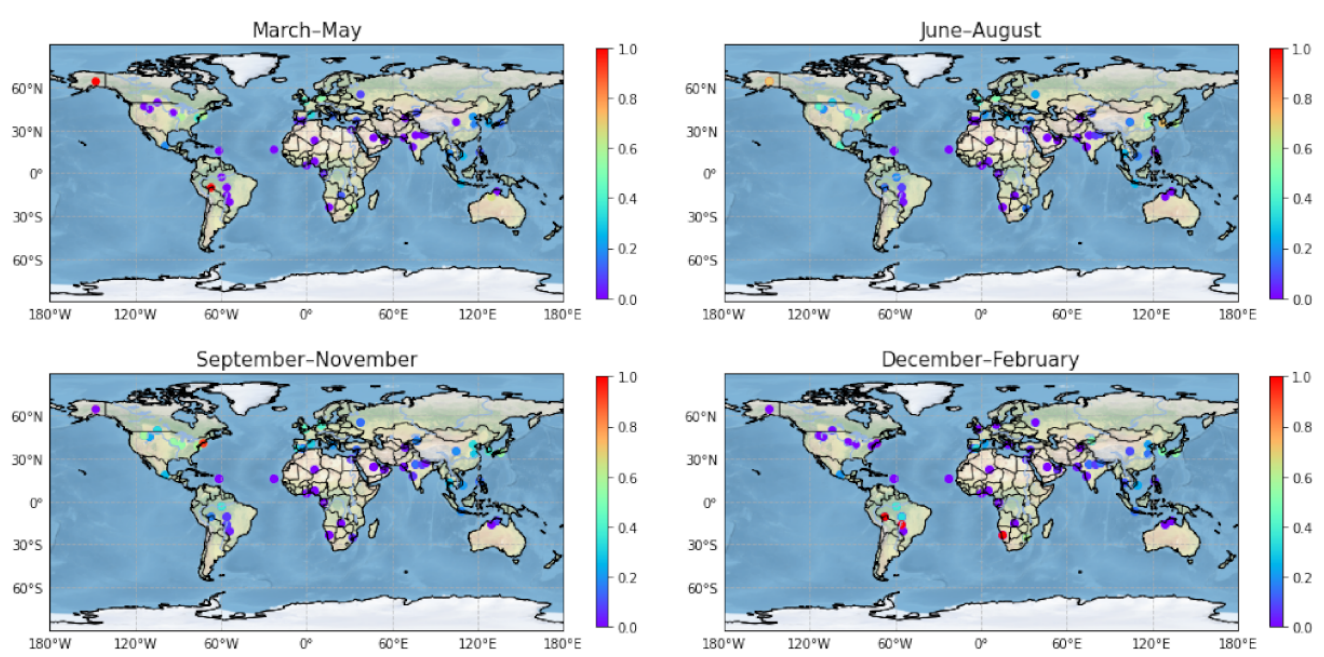
Figure 7. Temporal distribution of weakly absorbing aerosol. The color dot in each station implies the values of occurrence frequency in the color